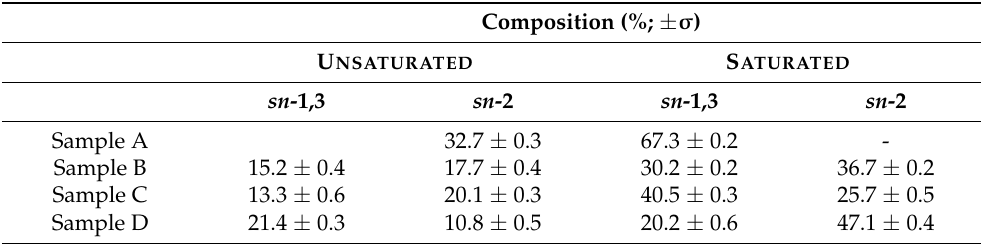
Table 4. 13 C qNMR regiospecific analysis for samples A (natural CB), B, C, and D. Because of only a relative and not an absolute quantitation via NMR was conducted, the composition in terms of unsaturated or saturated FAs in a stereospecific position is reported as a percentage (%). 13 C NMR results are the mean of three replicates. Each integration was carried out considering the carbonyl (C-1) and α -carbons (C-2) signals. Composition (%; ± σ ) U NSATURATED S ATURATED